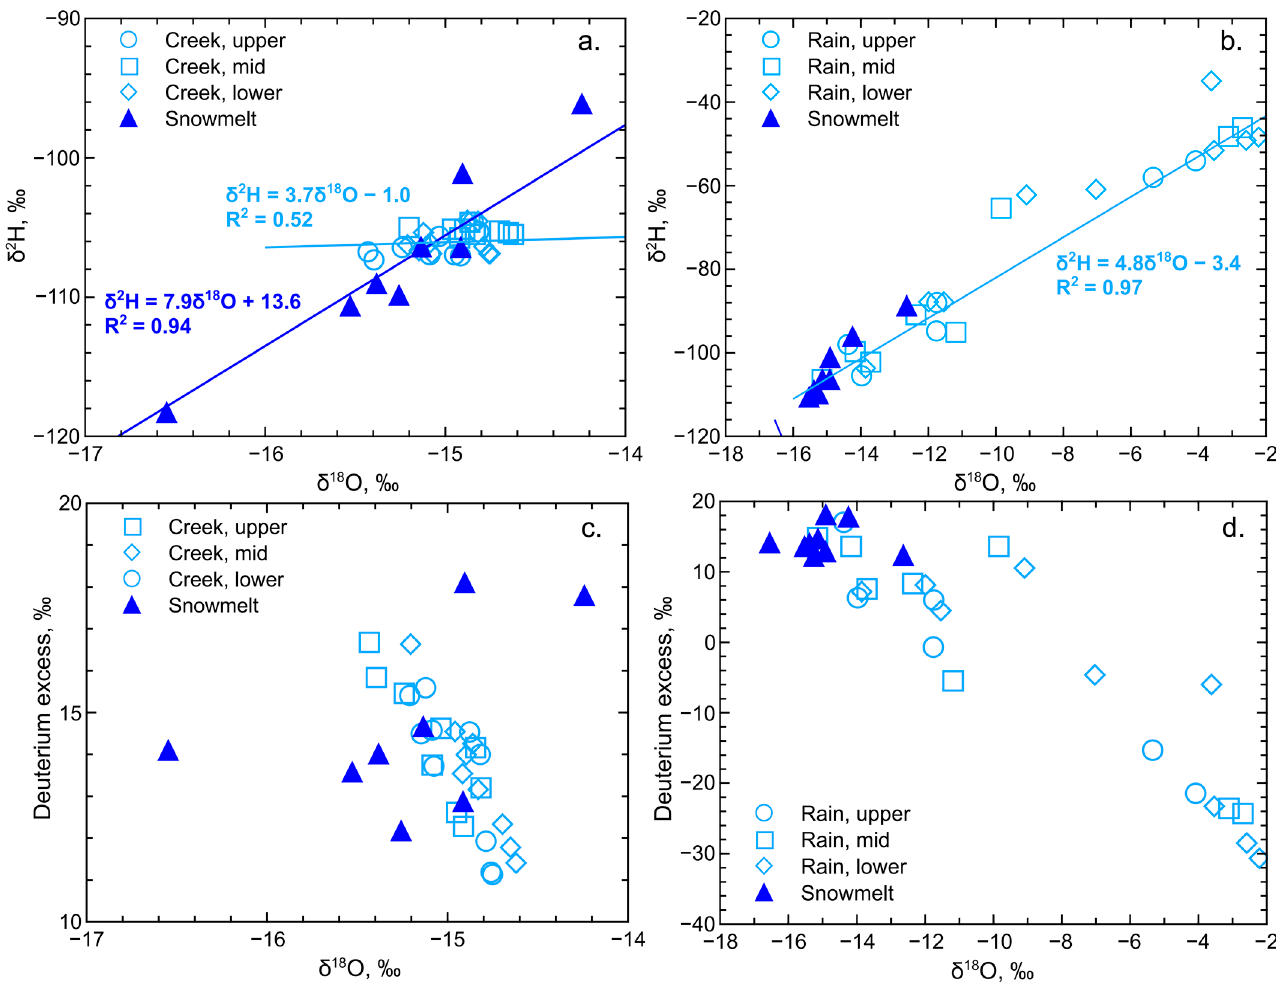
Figure 12. Deuterium excess and δ 18 O in source waters and groundwater in the South Fork Palouse River Basin.